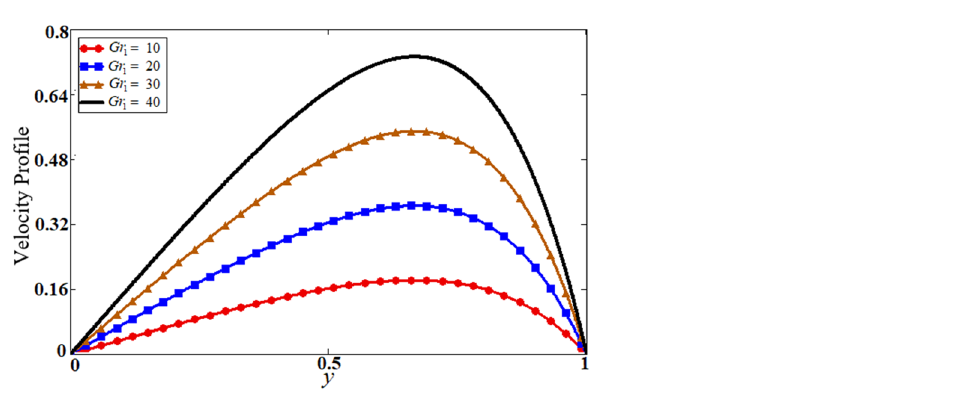
Figure 8. Results of heat generation Q on temperature and velocity.